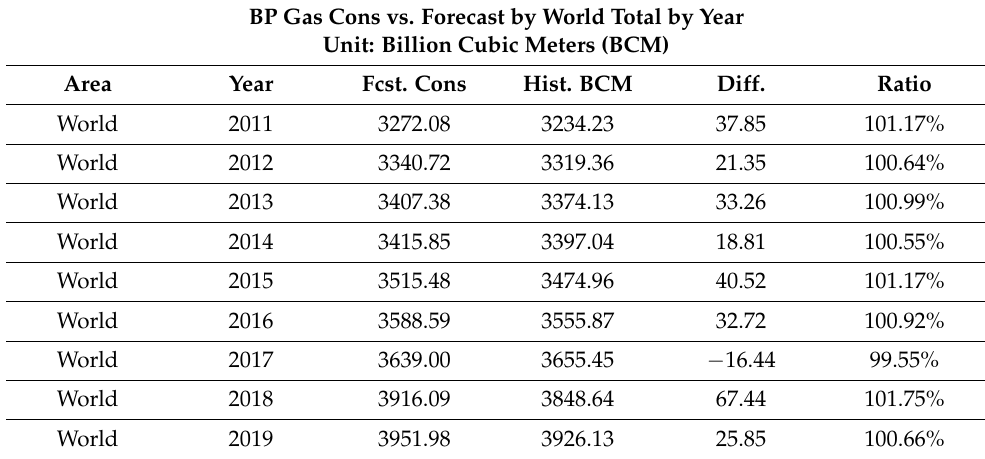
Table A2. G2M2 ® Forecasted Gas Consumption verus Report Historical by Year.